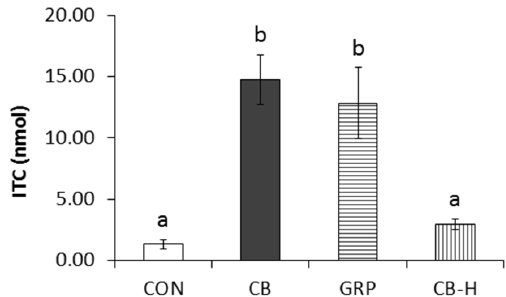
Figure 5. Rats were fed a 10% cooked broccoli (CB), GRP ‐ rich powder (GRP), broccoli pre ‐ hydrolyzed using myrosinase (CB ‐ H) or the control diet (CON) for four days ( n = 8). Concentrations of total isothiocyanate (ITC) were measured in rat cecal supernatant after incubation ex vivo with GRP (183 μ M) for 120 min. Data are mean ± SE. Values with similar letters are not different ( p < 0.05).